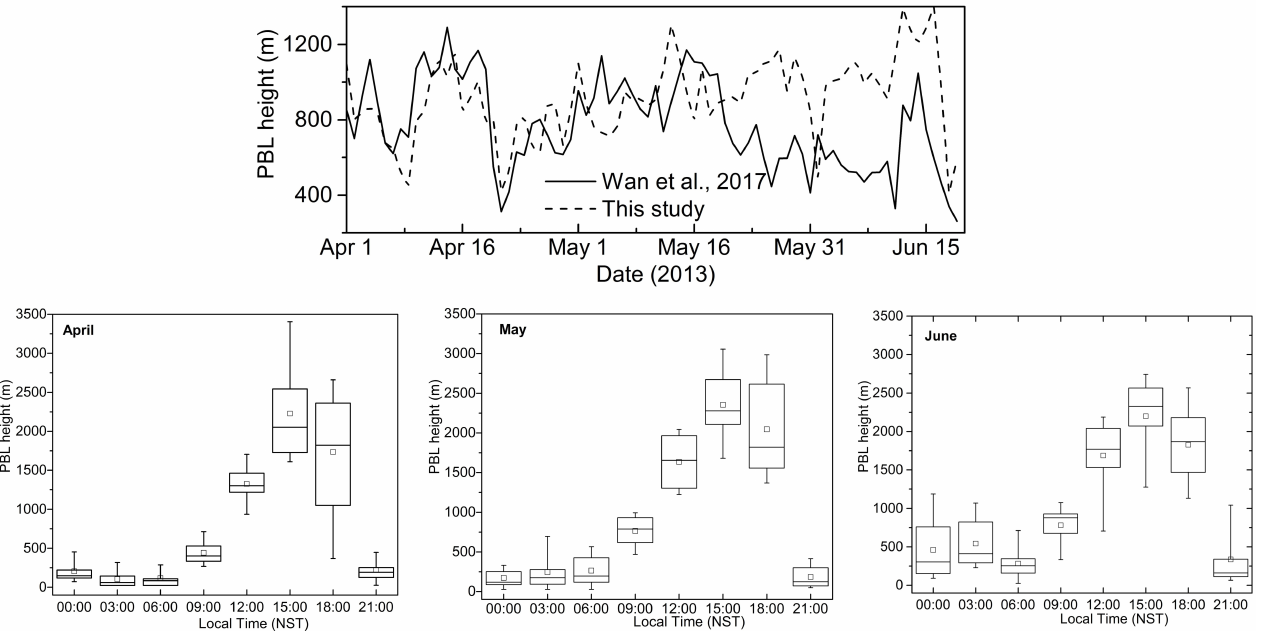
Figure 6. Daily time series of PBL height obtained from the model and reported values over Lumbini (obtained from Wan et al., 2017). The lower panel shows the monthly average diurnal variation of the PBL height. The square mark in each box represents the mean PBL height, the bottom and top of the box represent the 25th and 75th percentile and the top and bottom of the whisker represent the 90th and 10th percentile,